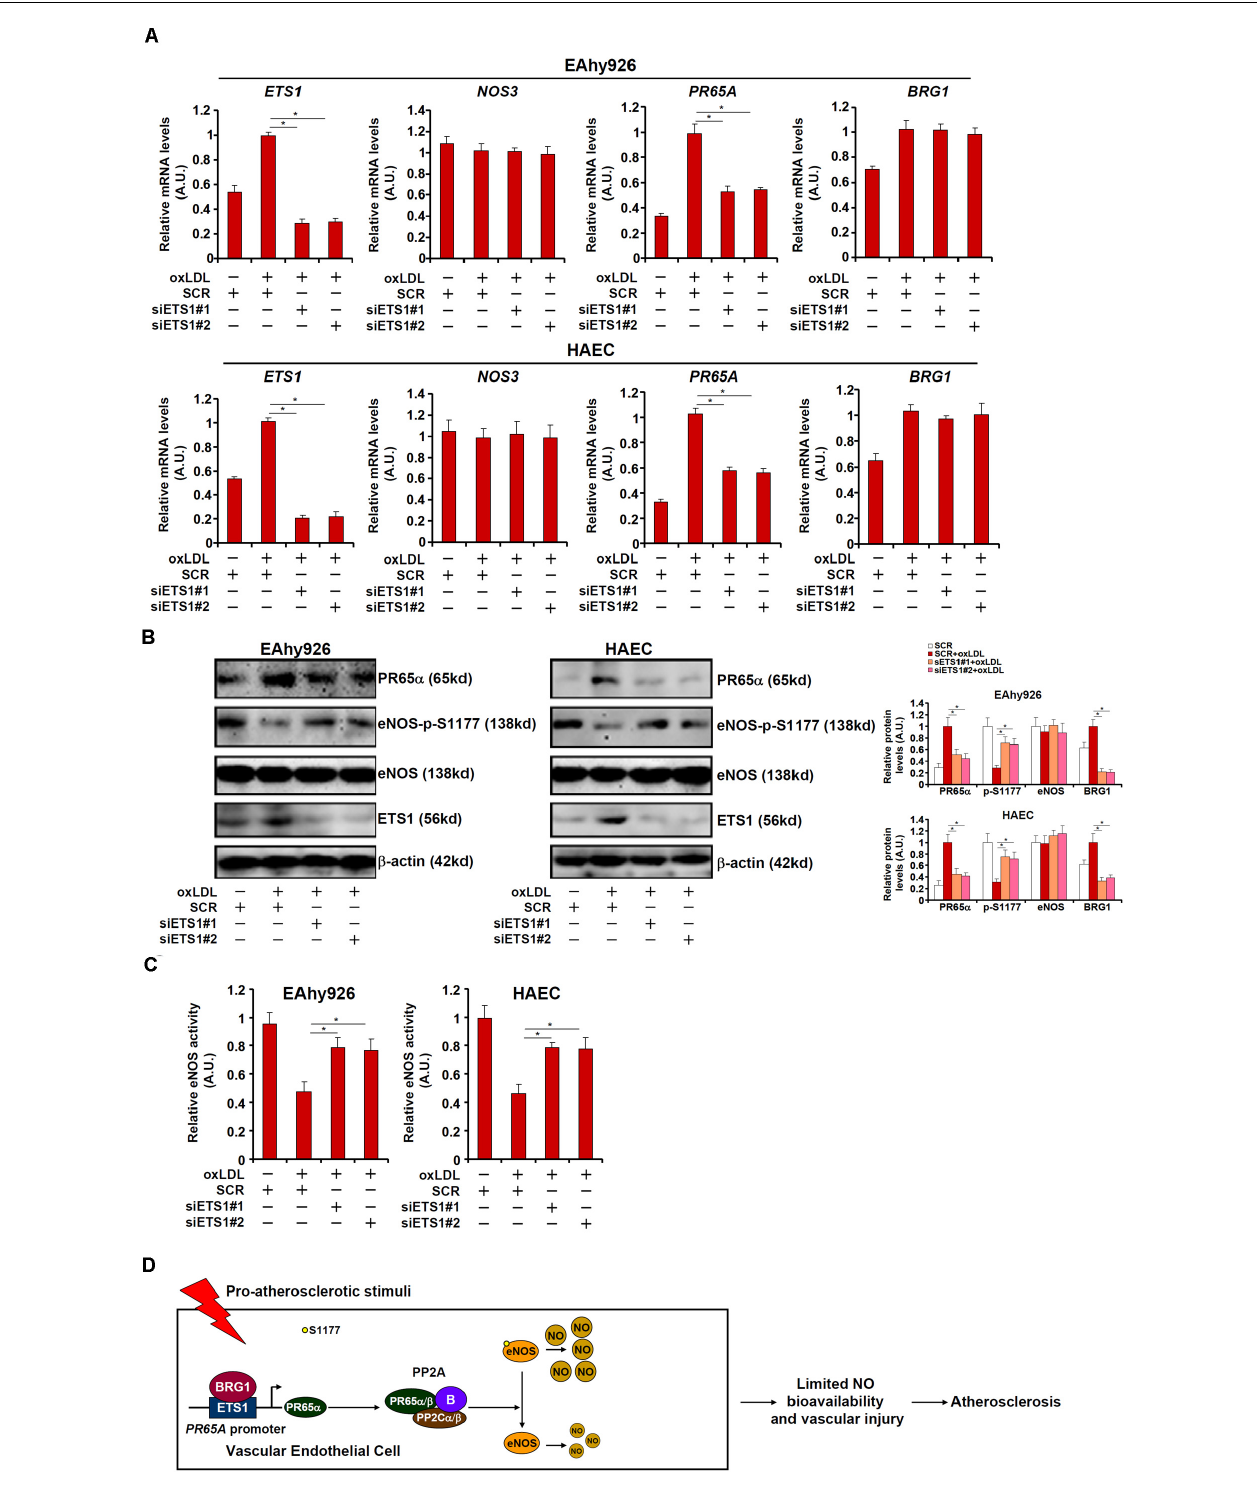
FIGURE 6 | ETS1 regulates NO bioavailability in endothelial cells. (A–C) EAhy296 cells and HAECs were transfected with siRNA targeting ETS1 followed by treatment with oxLDL (10 µ g/ml) for 24 h. NO content in the culture media was examined by the Griess assay. Gene expression levels were examined by qPCR and Western. (D) A schematic model. * p <